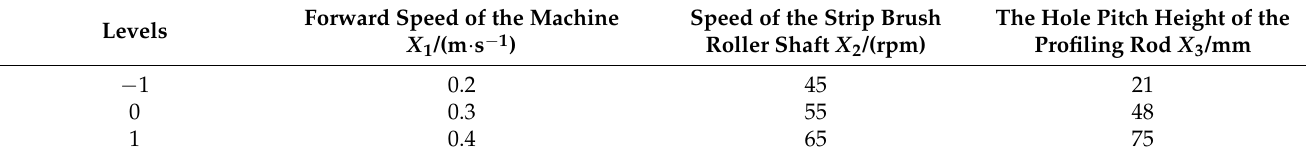
Table 3. Test factors and levels.